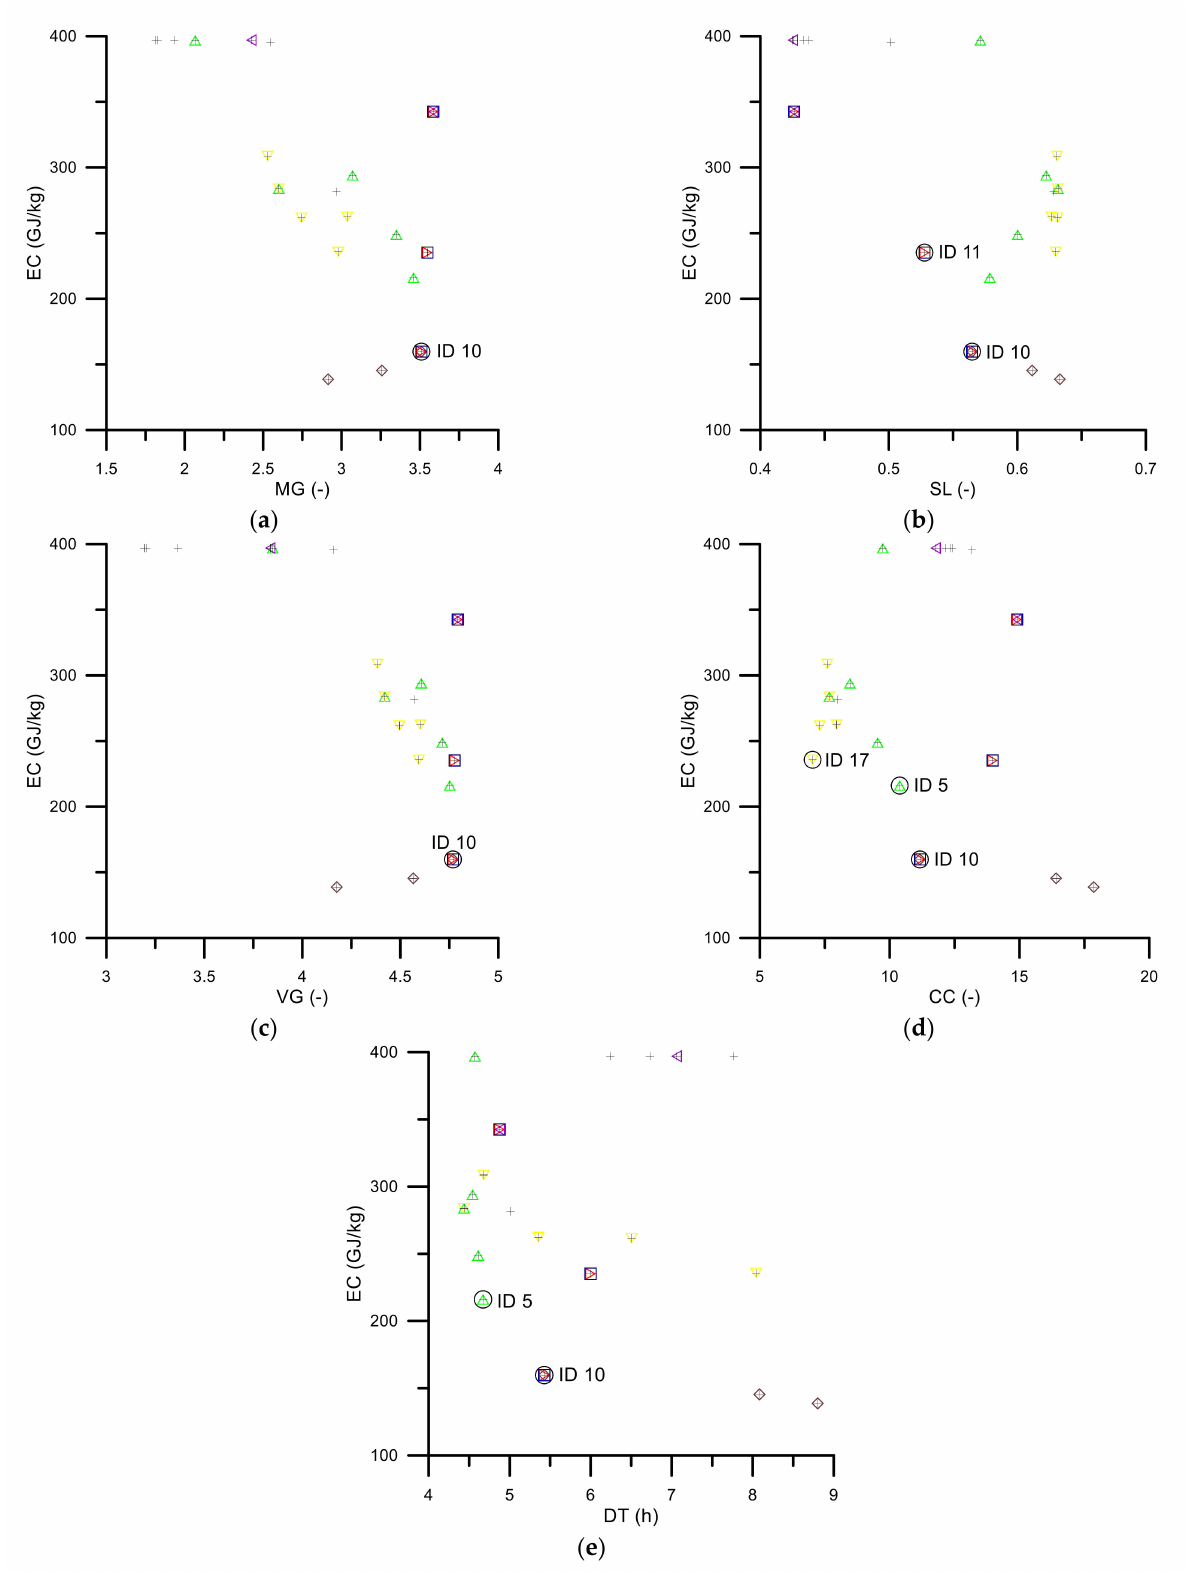
Figure 2. Pareto fronts: ( a ) EC-MG, ( b ) EC-SL, ( c ) EC-VG, ( d ) EC-CC, ( e ) EC-DT; +—data, O—the best solutions, —EC min , —MG max , —DT min , —CC min , —VG max -, —SL min